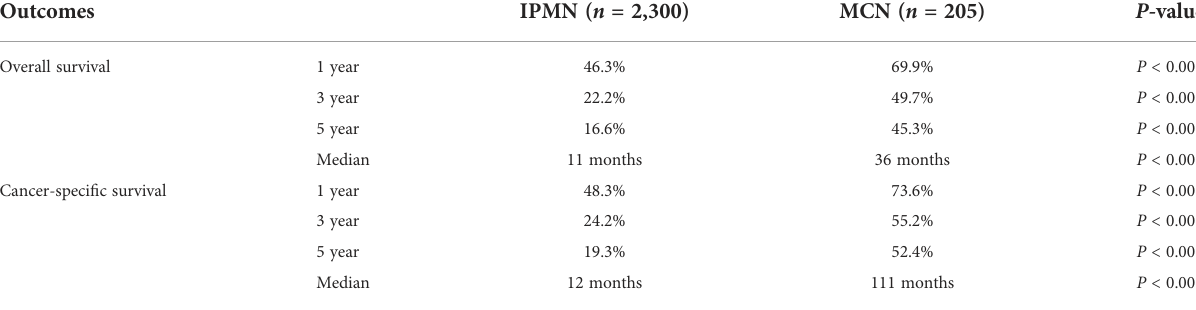
TABLE 2 Survival outcomes of patients with IPMN and